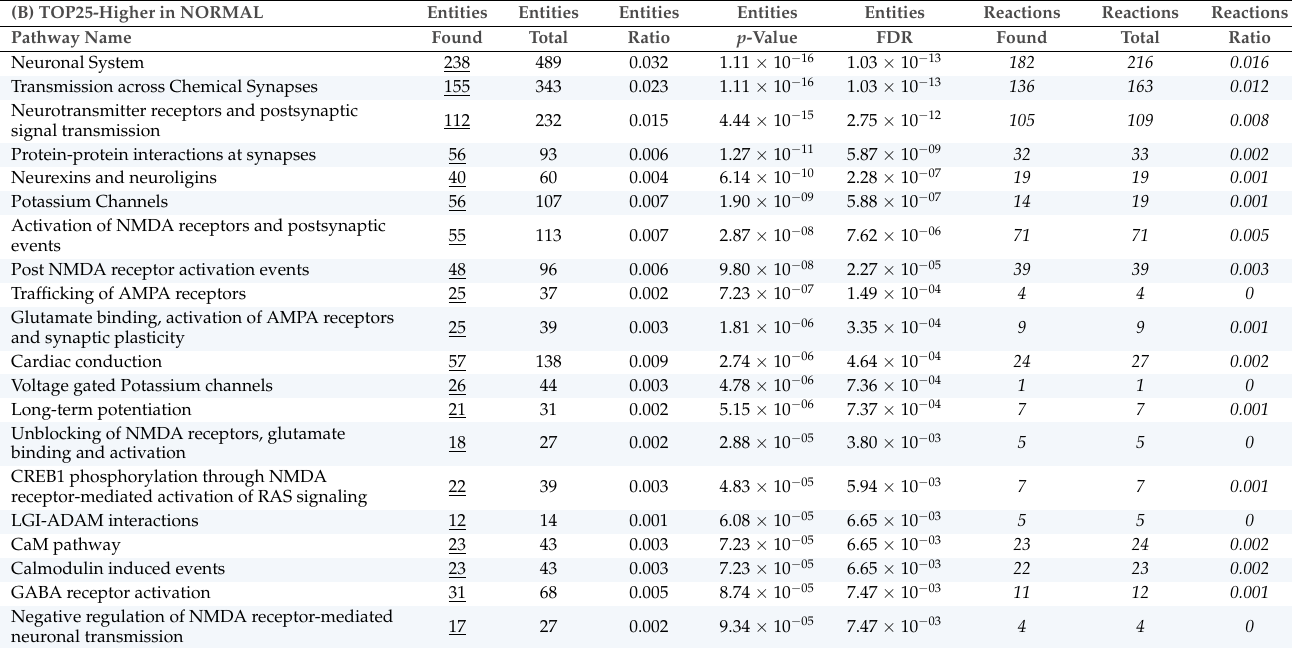
the contrasts: ion homeostasis (a); interaction between L1 and Ankyrins (b); unblocking of NMDA receptors, glutamate binding and activation, and L1CAM interactions